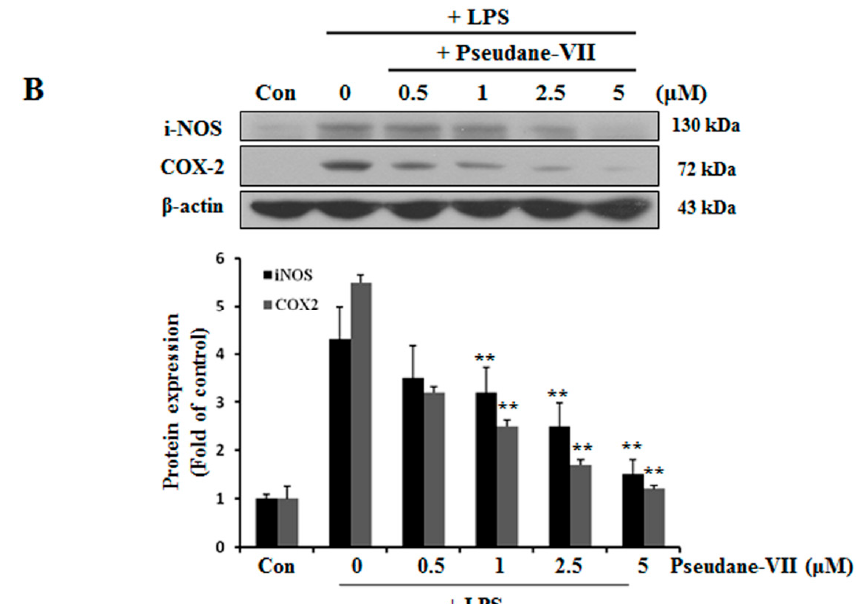
Figure 3. Pseudane-VII suppresses LPS-induced mRNA and protein level of iNOS and COX-2. ( A ) BV-2 microglial cells were treated with pseudane-VII (0.5, 1, 2.5, and 5 μ M) for 2 h and then added with LPS (200 ng/mL) for 6 h. Expression levels of mRNA were confirmed by RT-PCR. GAPDH was used as internal control. ( B ) BV-2 microglial cells were pretreated with various concentrations (0.5, 1, 2.5, and 5 µ M) for 2 h. After 2 h, cells were stimulated with LPS (200 ng/mL) for 24 h. An equal amount of cellular protein was separated by SDS-PAGE and transferred to the PVDF membranes. Membranes were attached to desired antibodies. β -actin was assessed as control. The result is representative of repeated four independent experiments. Experimental results were indicated as mean ( ± SE) (** p < 0.001 vs.